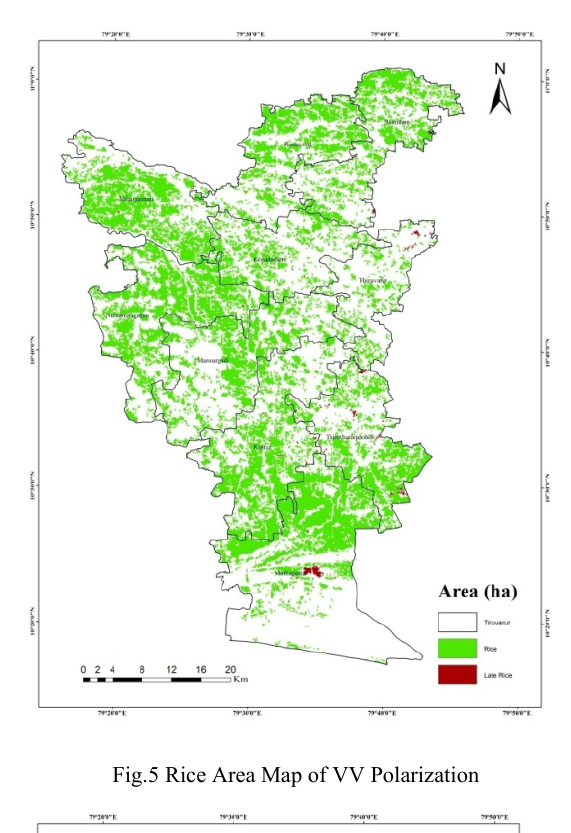
Fig.5 Rice Area Map of VV Polarization